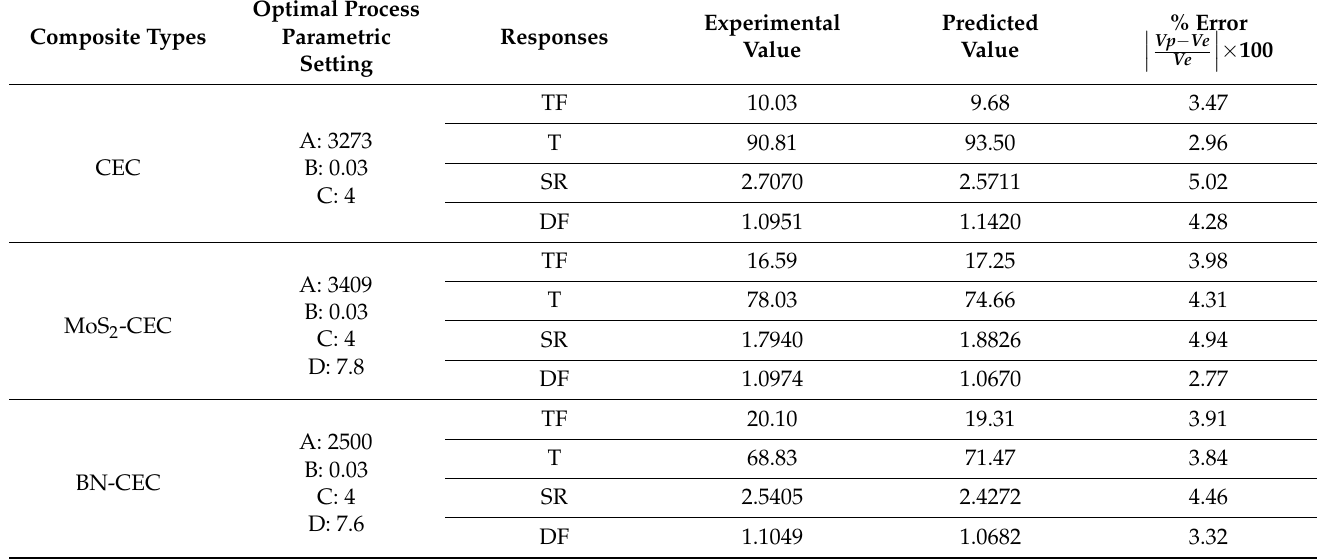
Table 18. Optimal combination based on multiple responses and confirmation test